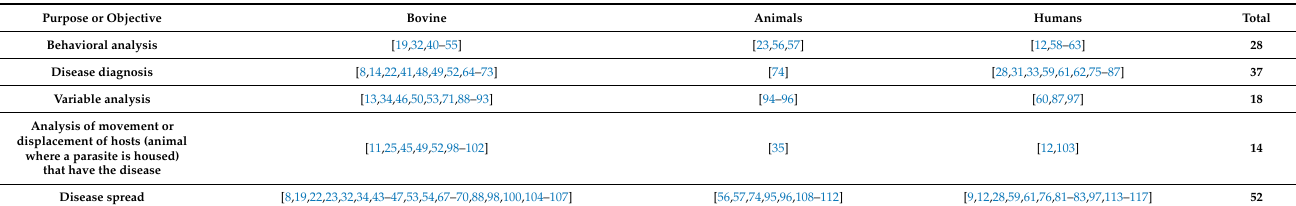
Table 1. Result of comparing related job–purpose or objective